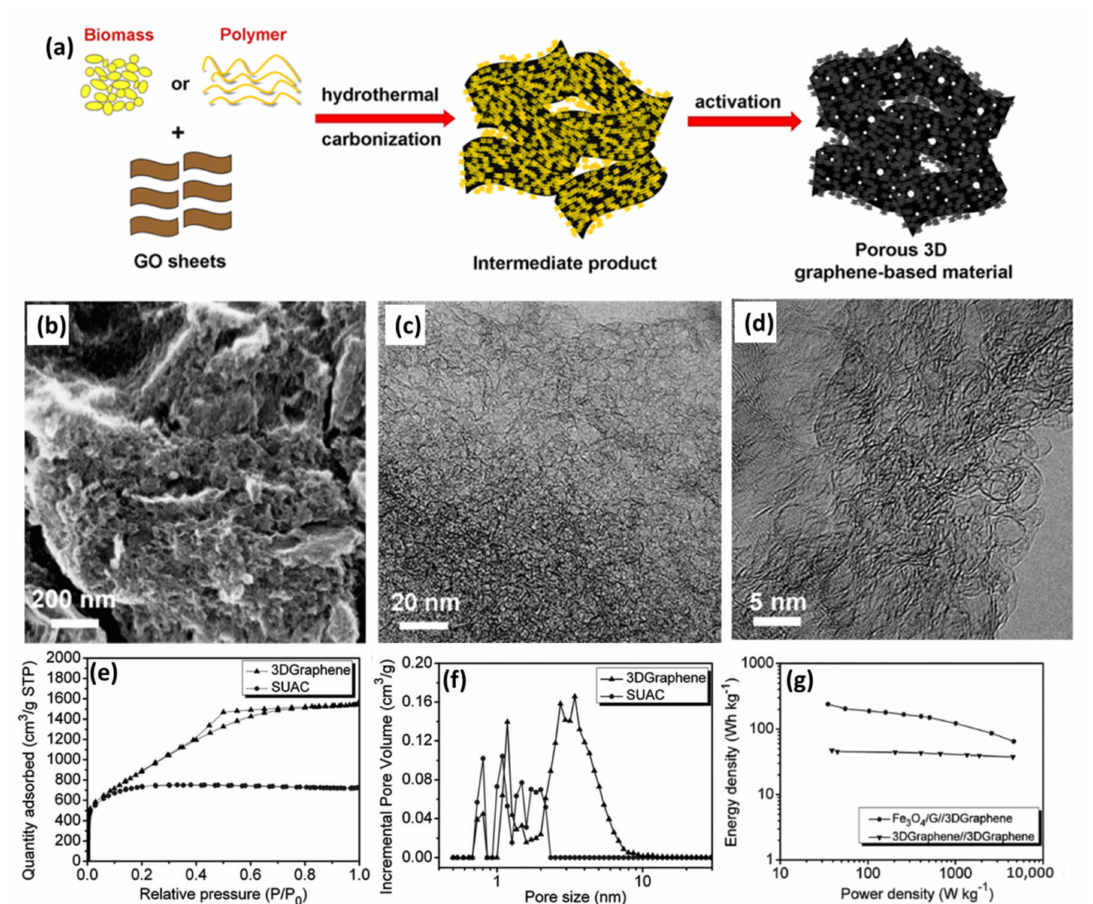
Figure 7. ( a ) Schematic of synthesizing porous 3D graphene-based materials; ( b ) SEM and ( c , d ) TEM images of 3DGraphene. (Reprinted with permission from Ref. [24]. Copyright 2013 Springer) ( e ) N 2 adsorption–desorption isotherms and ( f ) pore size distribution of sucrose-based 3DGraphene and pure sucrose-based AC as contrast; ( g ) Ragone plots of the Fe 3 O 4 /G//3DGraphene LICs and 3DGraphene//3DGraphene supercapacitors. (Reprinted with permission from Ref. [74]. Copyright 2013 Royal Society of